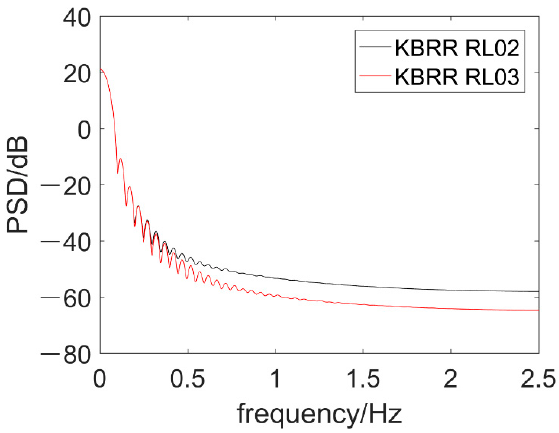
Figure 1. PSD of KBRR RL02 and RL03 data on 1 January